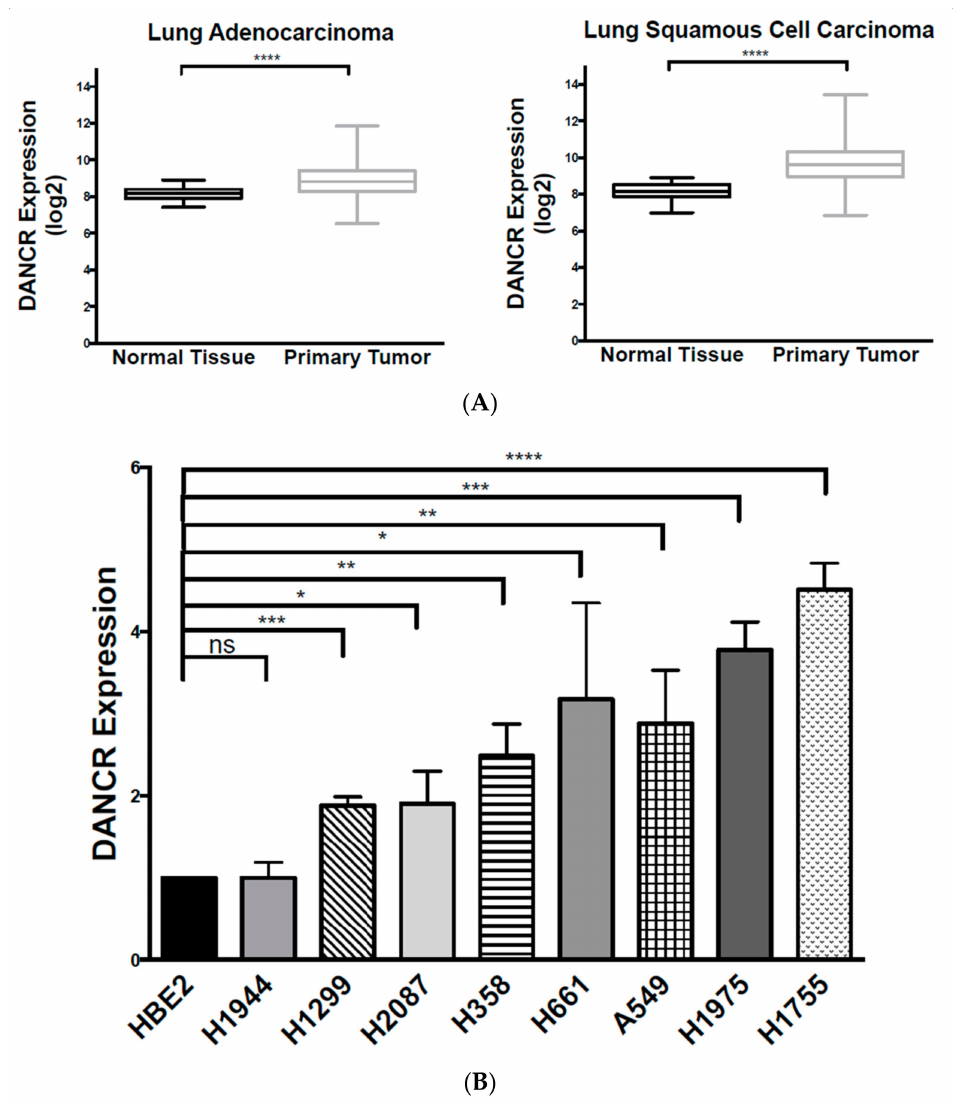
Figure 1. LncRNA-DANCR is highly upregulated in NSCLC tumors and cell lines. ( A ) Analysis of The Cancer Genome Atlas data for DANCR expression in primary lung adenocarcinoma ( n = 706) and squamous cell carcinoma ( n = 626) compared to normal lung tissue ( t test with Welch’s correction, **** p < 0.0001); ( B ) qRT-PCR measuring fold change of DANCR expression in NSCLC cell lines compared to lung epithelial cell line HBE2 normalized to 1 ( n = 3, t test, * p < 0.05, ** p < 0.01, *** p < 0.001, **** p <